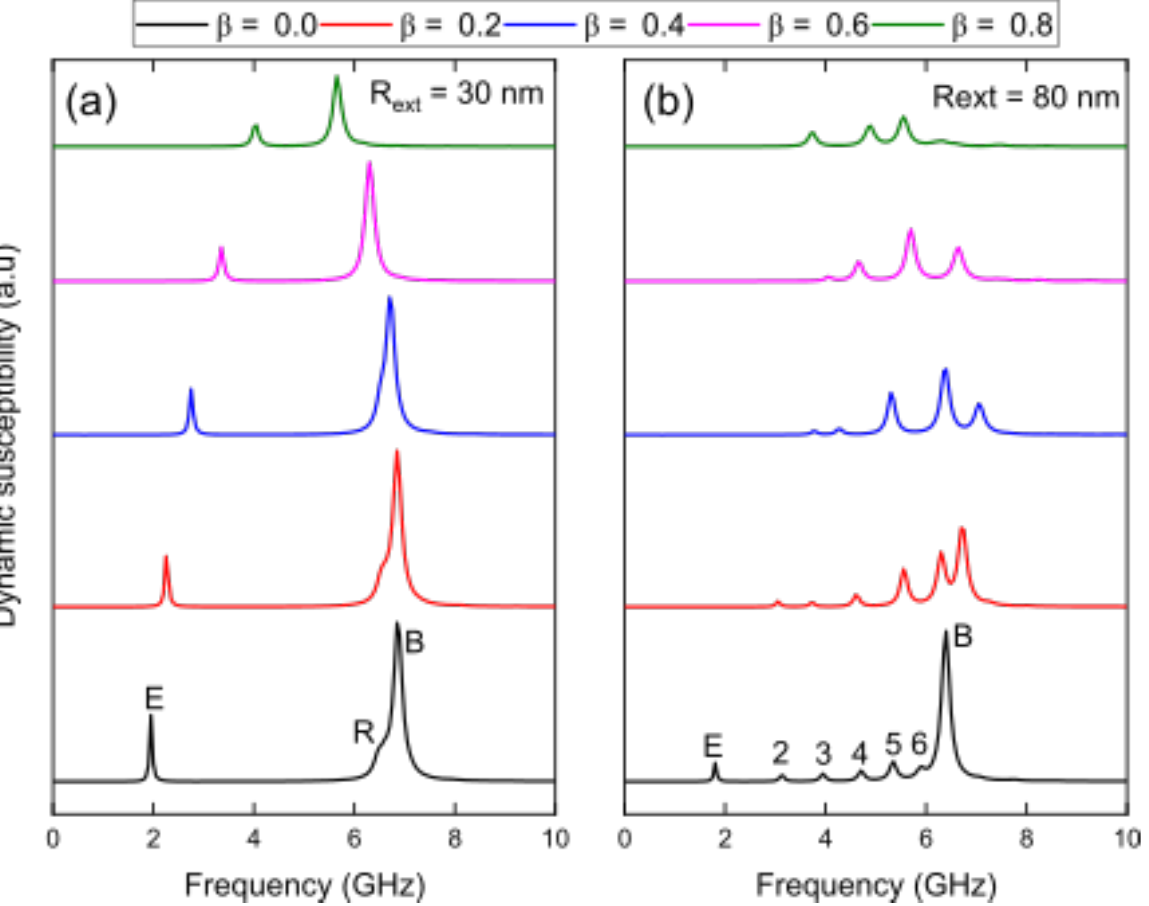
Figure 5. Evolution of dynamic susceptibility spectra for 1000 nm long Fe 3 O 4 nanotubes with external radius ( a ) R ext = 30 nm and ( b ) R ext = 80 nm, as a function of β values. The system is excited with a sinc wave field in the y -direction.